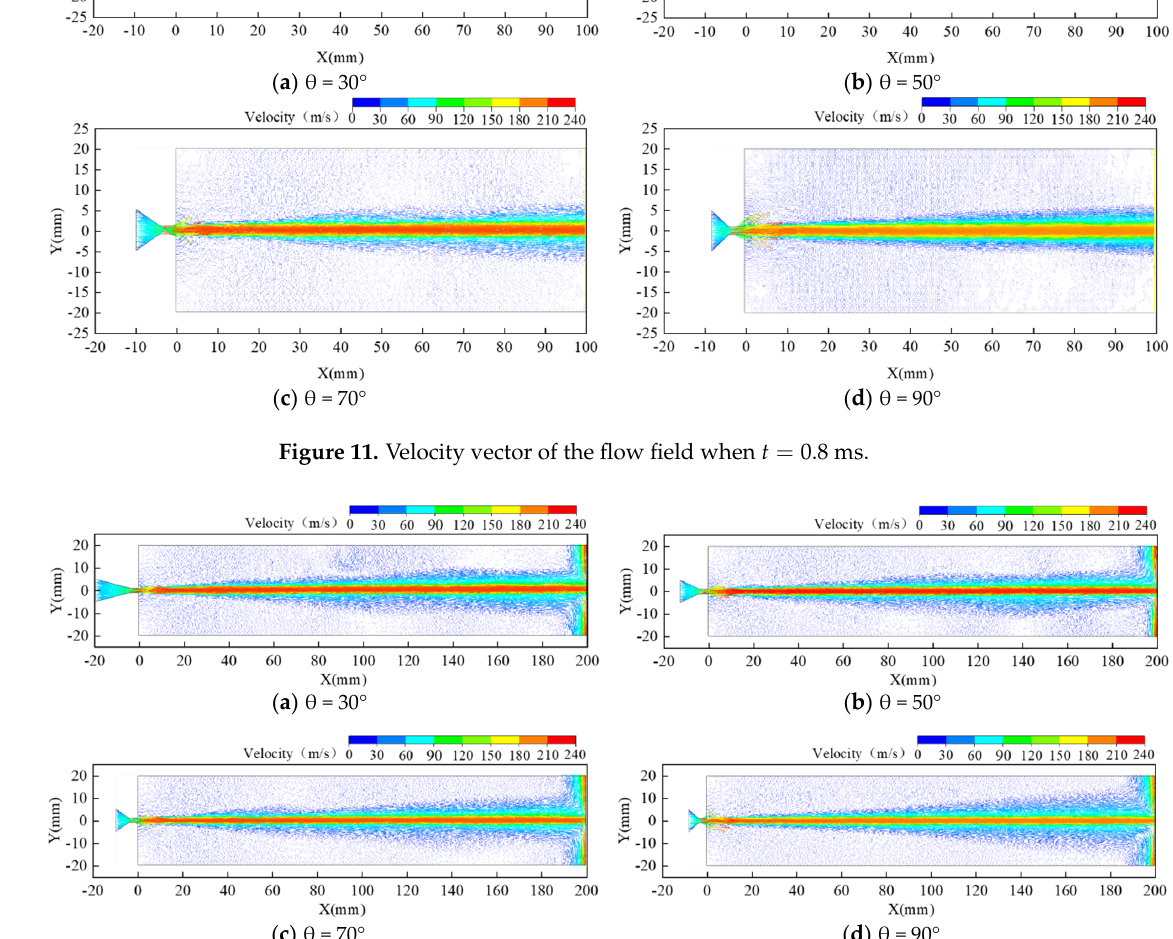
Figure 12. Velocity vector of the flow field when t = 2 ms.